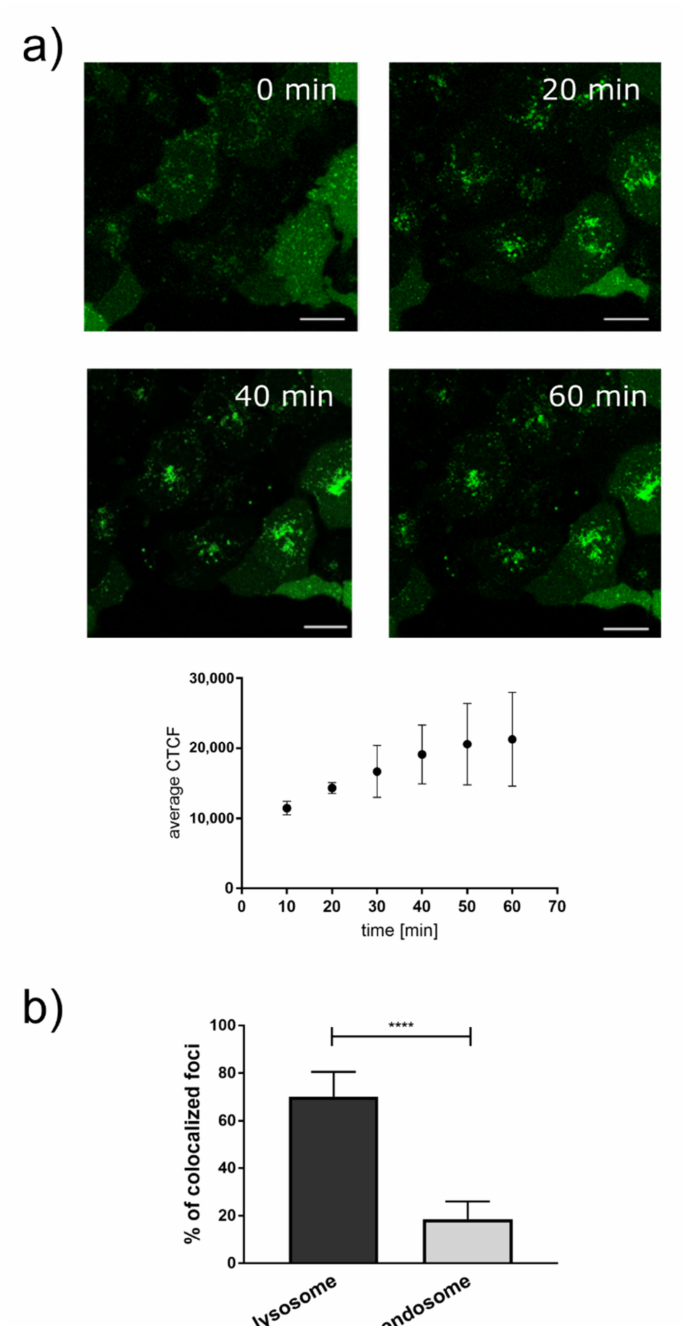
Figure 4. ( a ) Representative images of the increase in the Ap4 fluorescence intensity (green) in live HeLa cells as a function of time; scale bar: 20 µ m. The plot below shows the quantitative average increase in the corrected total cell fluorescence (CTCF) with respect to time. The values indicate the average of 20 cells and the error bars indicate the standard deviation of the mean. ( b ) Comparison of the colocalization of Ap4 hydrolysis with lysosomes and that of endosomes. Error bars represent the SD (N = 20). Statistical significance determined by one-way ANOVA, **** p <